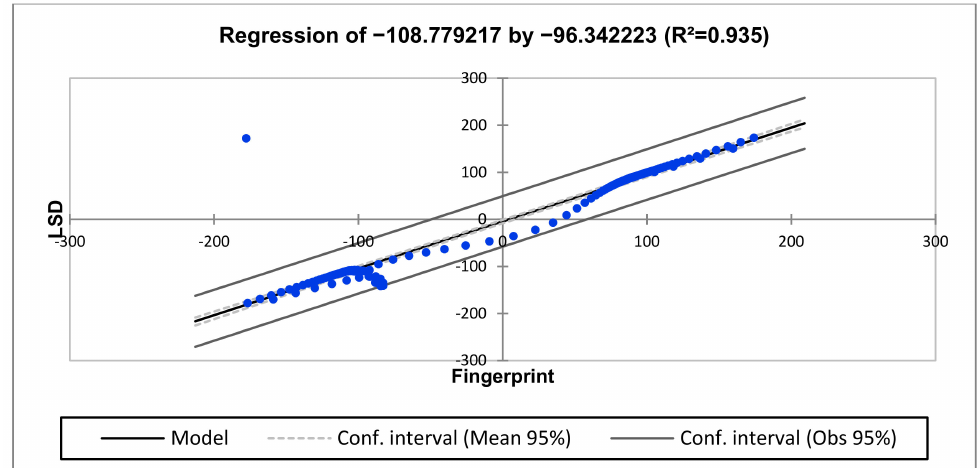
Figure 15. Regression of Phase C, tap position 1 (medium-frequency region).